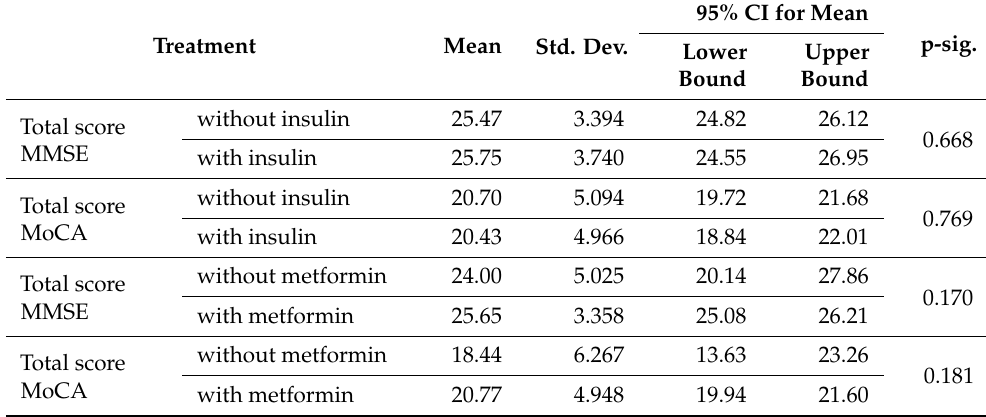
Table 5. Differences in MMSE and MoCA scores according to treatment.